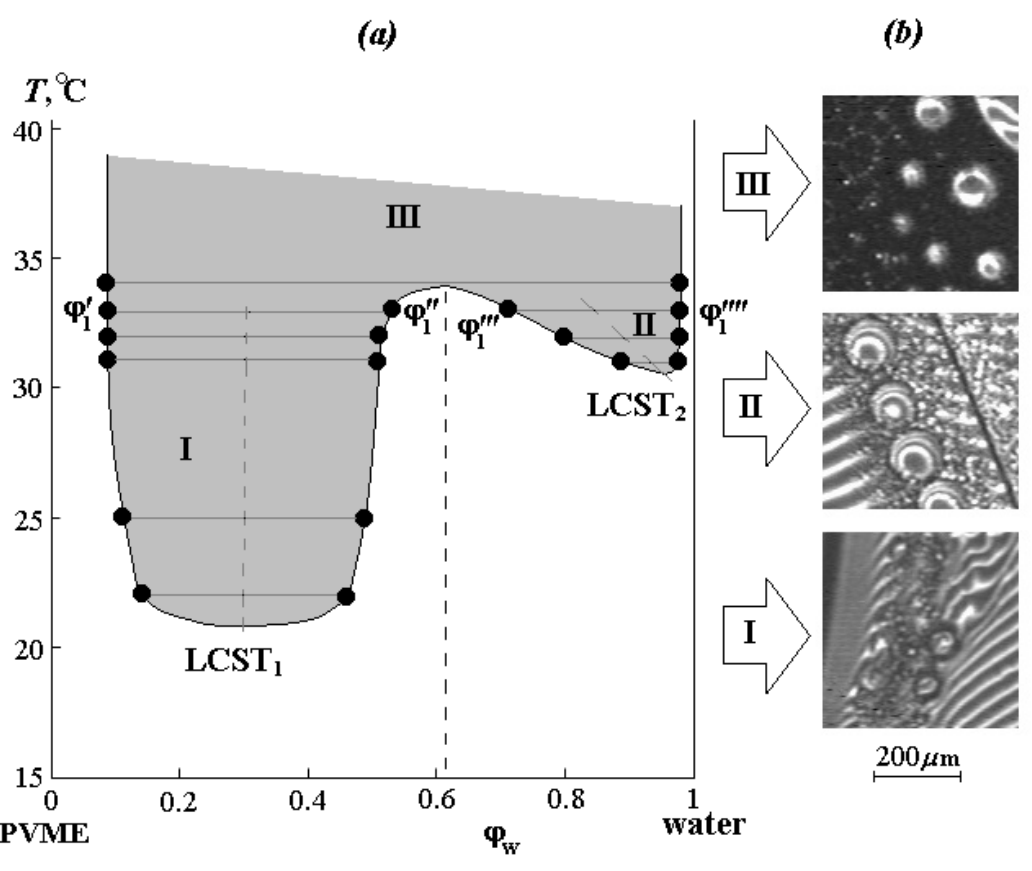
Figure 3. ( a ) PVME-water system phase state diagrams and ( b ) microphotographs of the phase structure for different zones (see text for details).